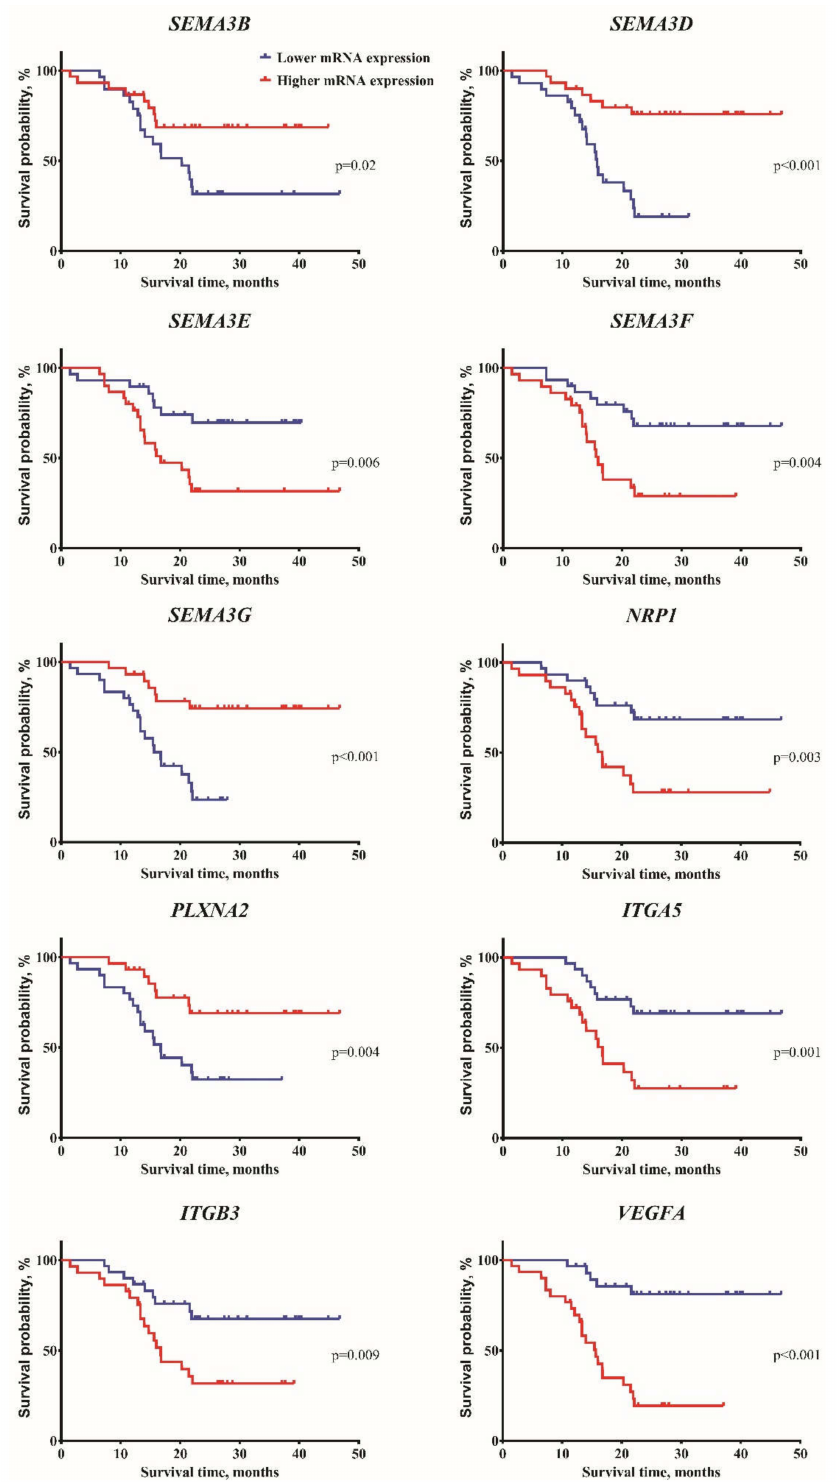
Figure 3. Kaplan-Meier survival curves of SEMA3 pathway genes. Astrocytoma patients (n = 59) divided into two mRNA expression groups (lower and higher) according to the median of the gene expression. Log-rank test, p <